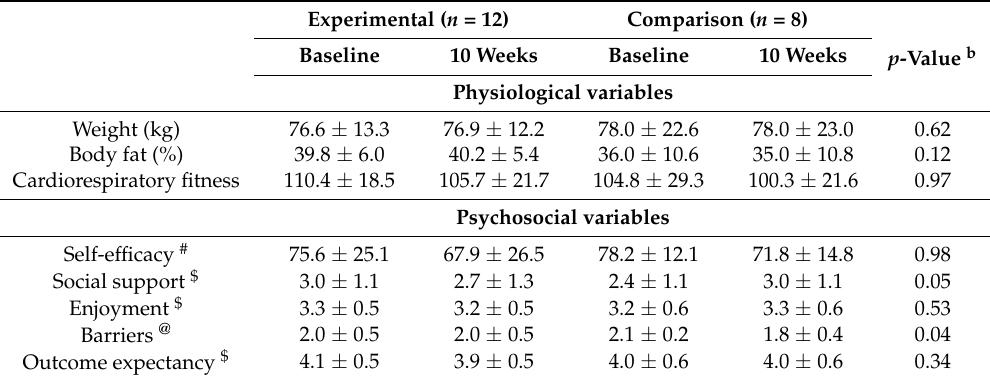
Table 4. Descriptive statistics for physiological and psychosocial variables by group at baseline and 10 weeks * ,a